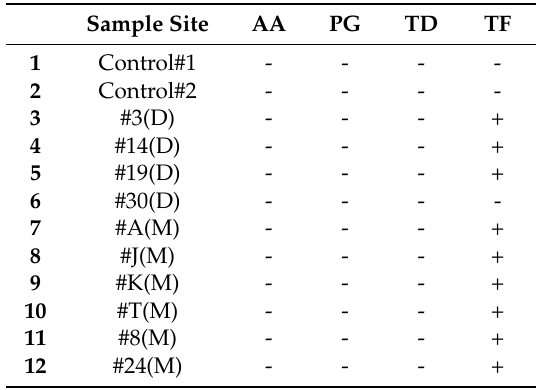
Figure 5. Both pictures show the normal dentin ( a ) surrounded by normal cementum ( b ). The picture on the right magnifies the border between the two structures, which appear to be normal. Table 1. Periodontal pathogen distribution table by tooth